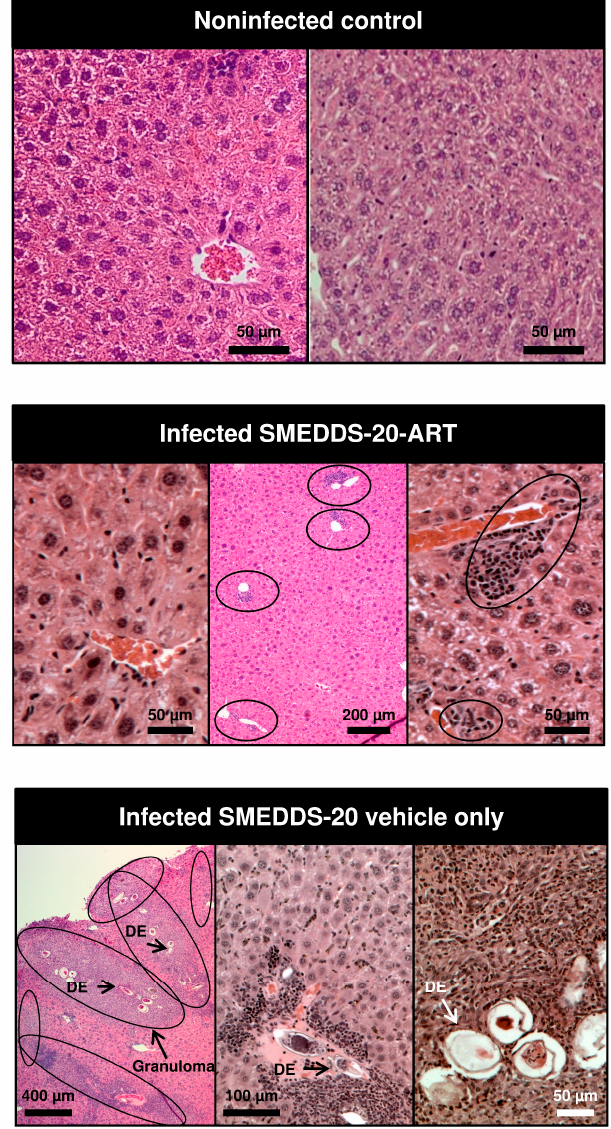
Figure 9. Liver histology, H&E stained, top: non-infected control; middle: artemisone-treated mice infected with S. mansoni . IC = inflammatory cells; bottom: infected mice treated with drug-free SMEDDS-20, DE = degenerated